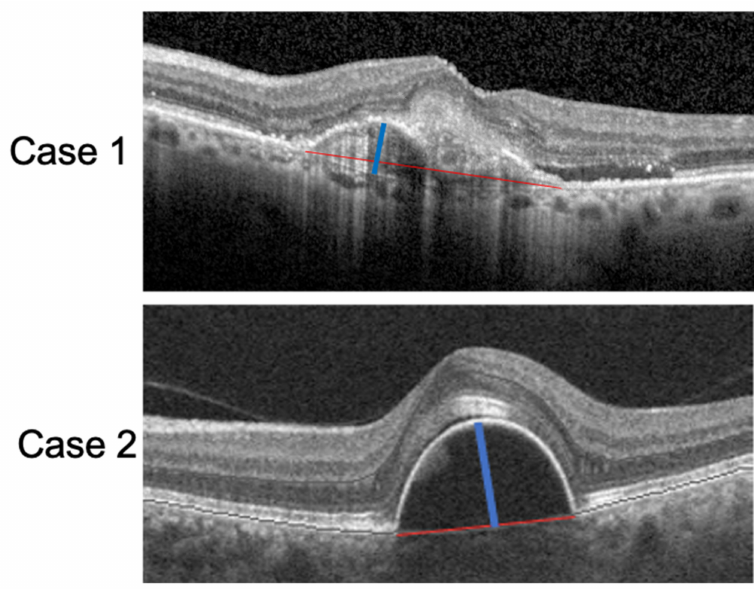
Figure 1. SD-OCT scan of two patients with a PED. The red lines correspond to the PED-HMDs and the blue lines to the PED-MHs.